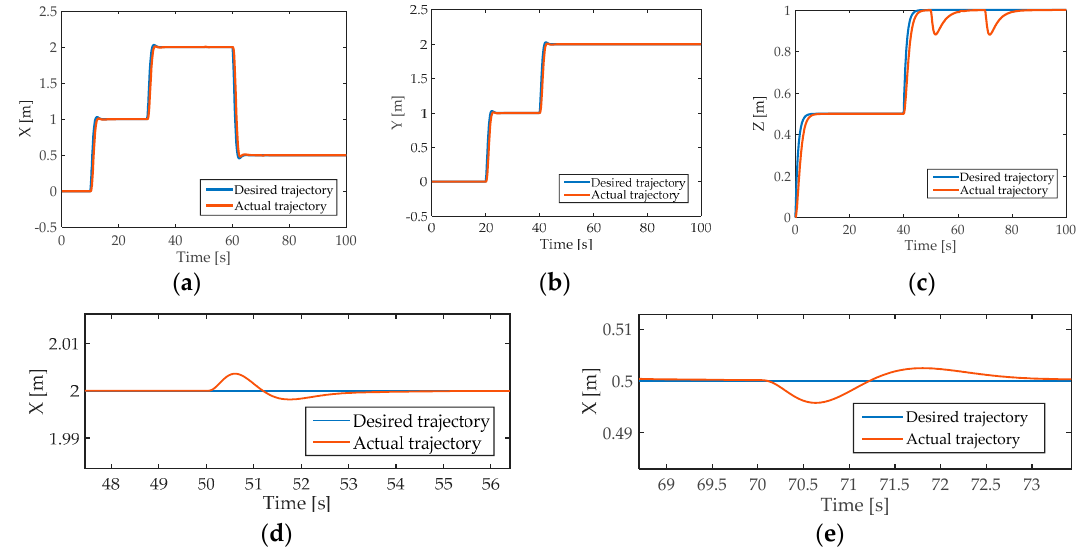
Figure 11. Tracking performance in three positions: ( a ) x -direction; ( b ) y -direction; ( c ) z -direction; ( d ) zoomed x -direction at 50 s; ( e ) zoomed x -direction at 70 s.